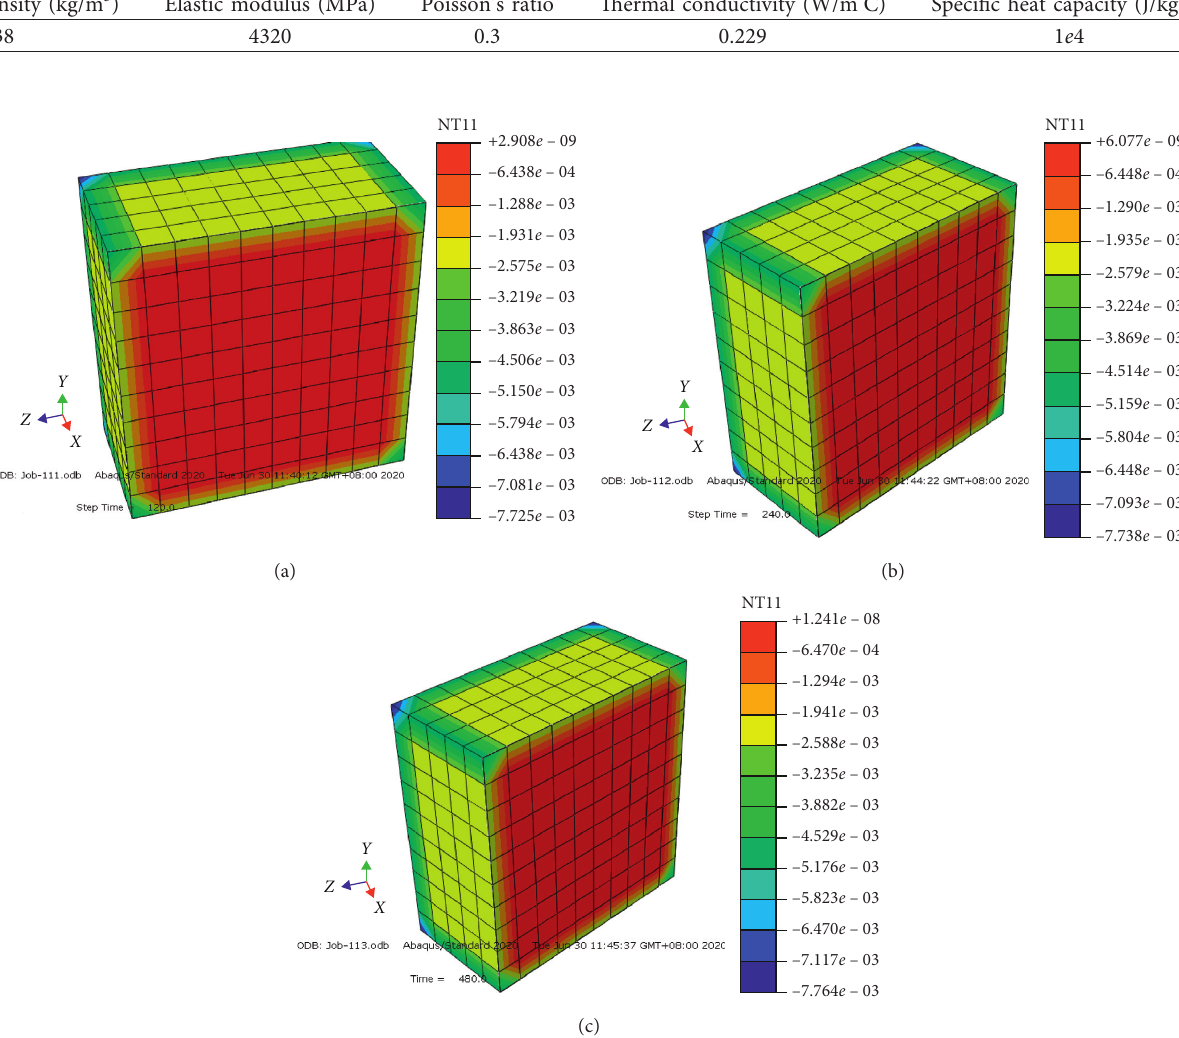
Figure 4: Temperature distribution map of rock freeze-thaw cycle: (a) 5 freeze-thaw cycles, (b) 10 freeze-thaw cycles, and (c) 20 freeze-thaw